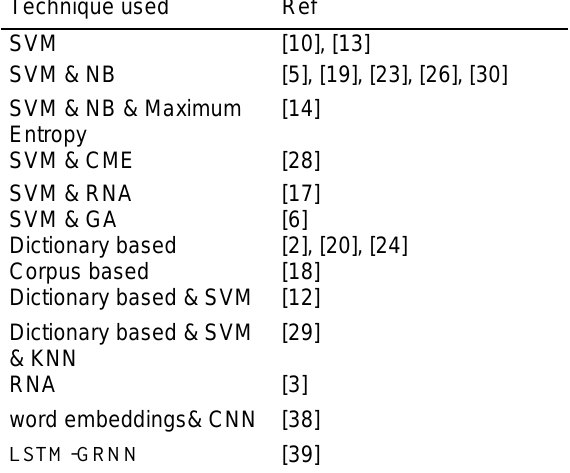
Table 2. Comparative study by technique